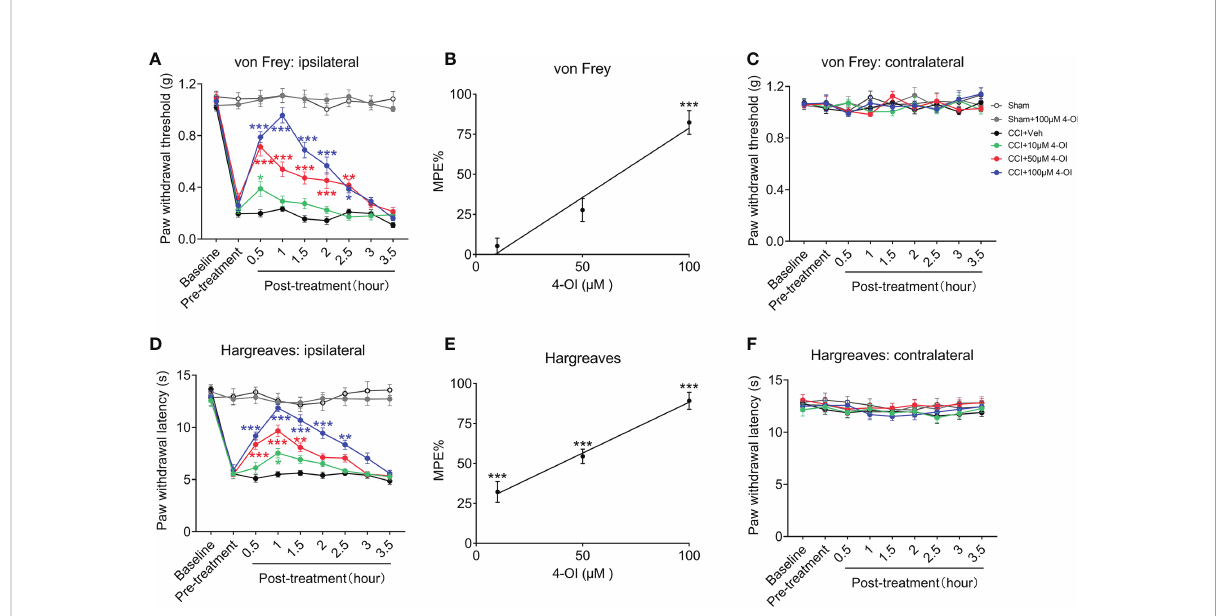
FIGURE 4 Intrathecal injection of 4-OI alleviated the pain hypersensitivity in male CCI mice. (A) The effect of local application of 4-OI on the PWT of ipsilateral hind paw in male CCI mice at 14th days post injury. (B) The maximum possible effect (MPE) of PWT at 2 hours post 4-OI was calculated. (C) The effect of 4-OI on the PWT of contralateral hind paw. (D) The effect of local application of 4-OI on the PWL of ipsilateral hind paw in male CCI mice at 14th days post injury. (E) The MPE of PWL at 2 hours post 4-OI was calculated. (F) The effect of 4-OI on the PWL of contralateral hind paw. Data are presented as mean ± SEM. *** p <0.001, ** p <0.01, * p <0.05 vs. CCI + Veh, followed by two-way ANOVA (A, D) and one-way ANOVA (B, E) with Tukey ’ s and Dunnett ’ s multiple comparisons test (n =